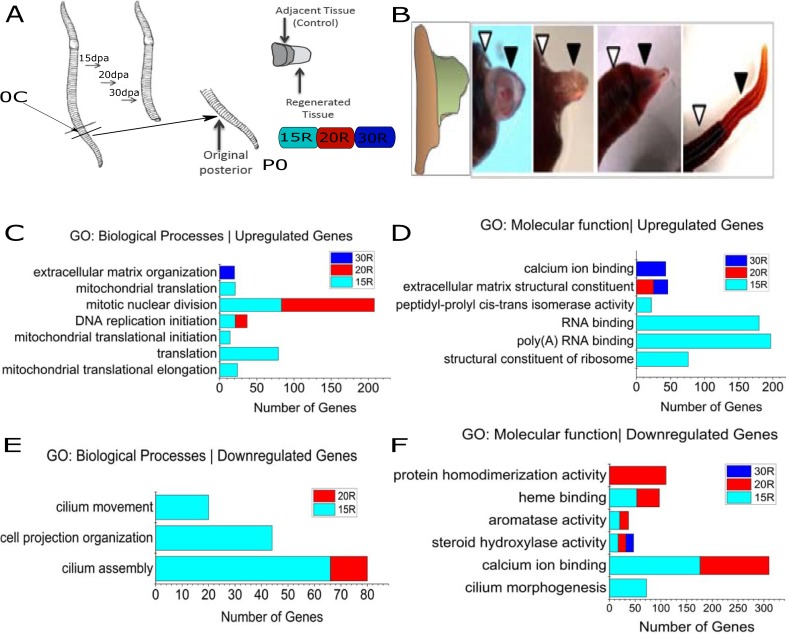
Functional classification of differentially expressed genes in the regenerating earthworm.(A) Schematic representation of the experiment: Earthworms were cut (transverse) at 60 ± 6 segments from the anterior end and anterior portion was allowed to regenerate for 15, 20 or 30 days. At 15, 20 and 30 days post amputation (dpa), the regenerated tissue and the (old) adjacent control tissue was collected. Total RNA was used for RNA-Seq analysis. (B) A typical worm during various stages of regeneration showing the regenerating tissue (filled arrowhead) and the adjacent tissue (open arrowhead). Gene ontology classification by DAVID revealed GO terms over-represented in the (C-D) upregulated genes and (E-F) downregulated genes (Benjamini Hochberg adjusted pVal ≤ 10-4).